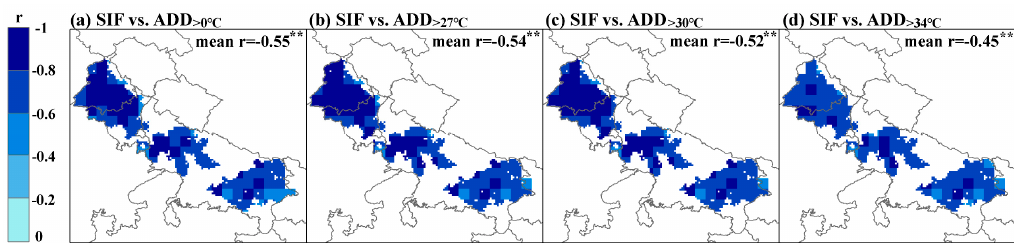
Figure 4. Pearson correlation coe ffi cients (r) between the mean solar-induced chlorophyll fluorescence (SIF) and ADD over ( a ) 0 ◦ C, ( b ) 27 ◦ C, ( c ) 30 ◦ C, and ( d ) 34 ◦ C in March–April. Colored pixels are statistically significant (p < 0.05). The mean r is the average of the correlation coe ffi cients at the district scale and stars indicate statistical significance (**: p < 0.05).